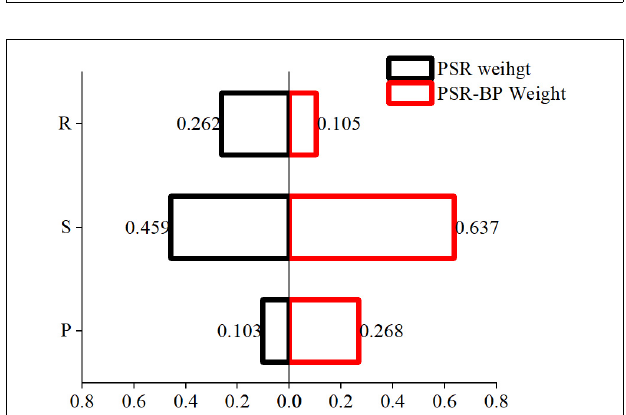
FIGURE 5 | The comprehensive score of Huangshui wetland health based on the PSR-BP neural network. Yellow represents 2016; pink represents 2017; green represents 2018; blue represents 2019. P (Pressure); S (State); R (Response).